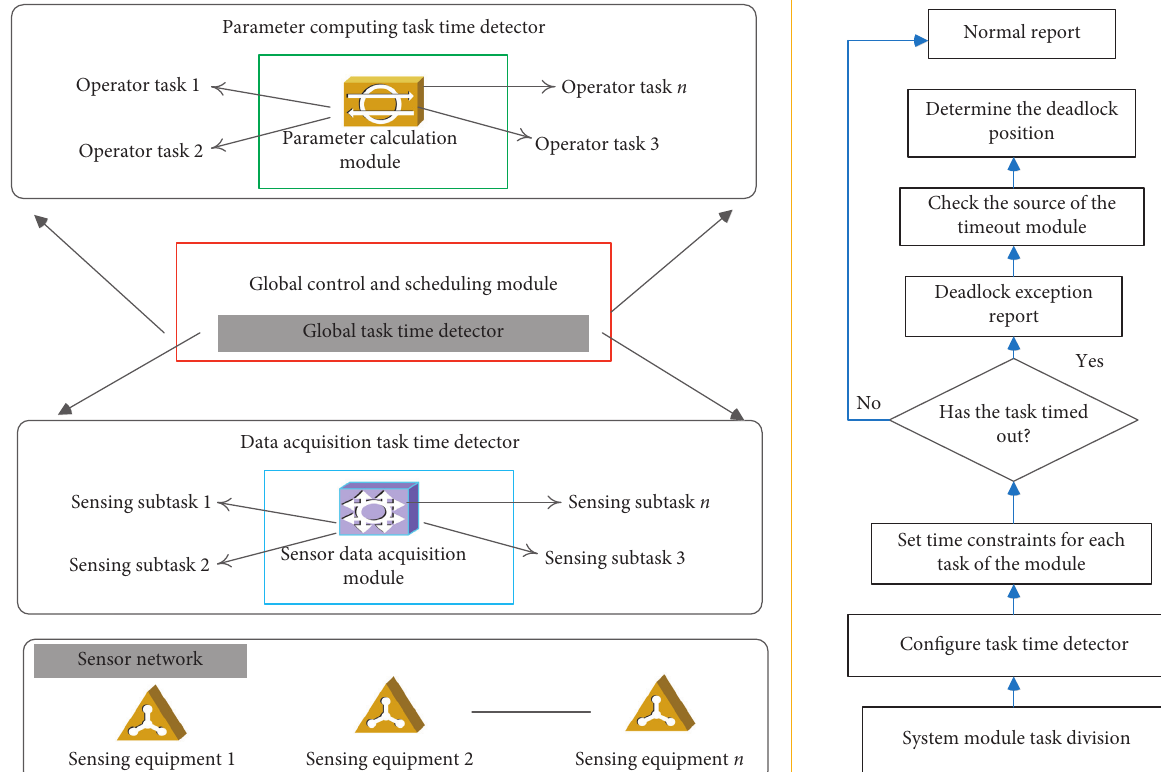
Figure 3: Model diagram of deadlock detection method for hierarchical scheduling system based on time